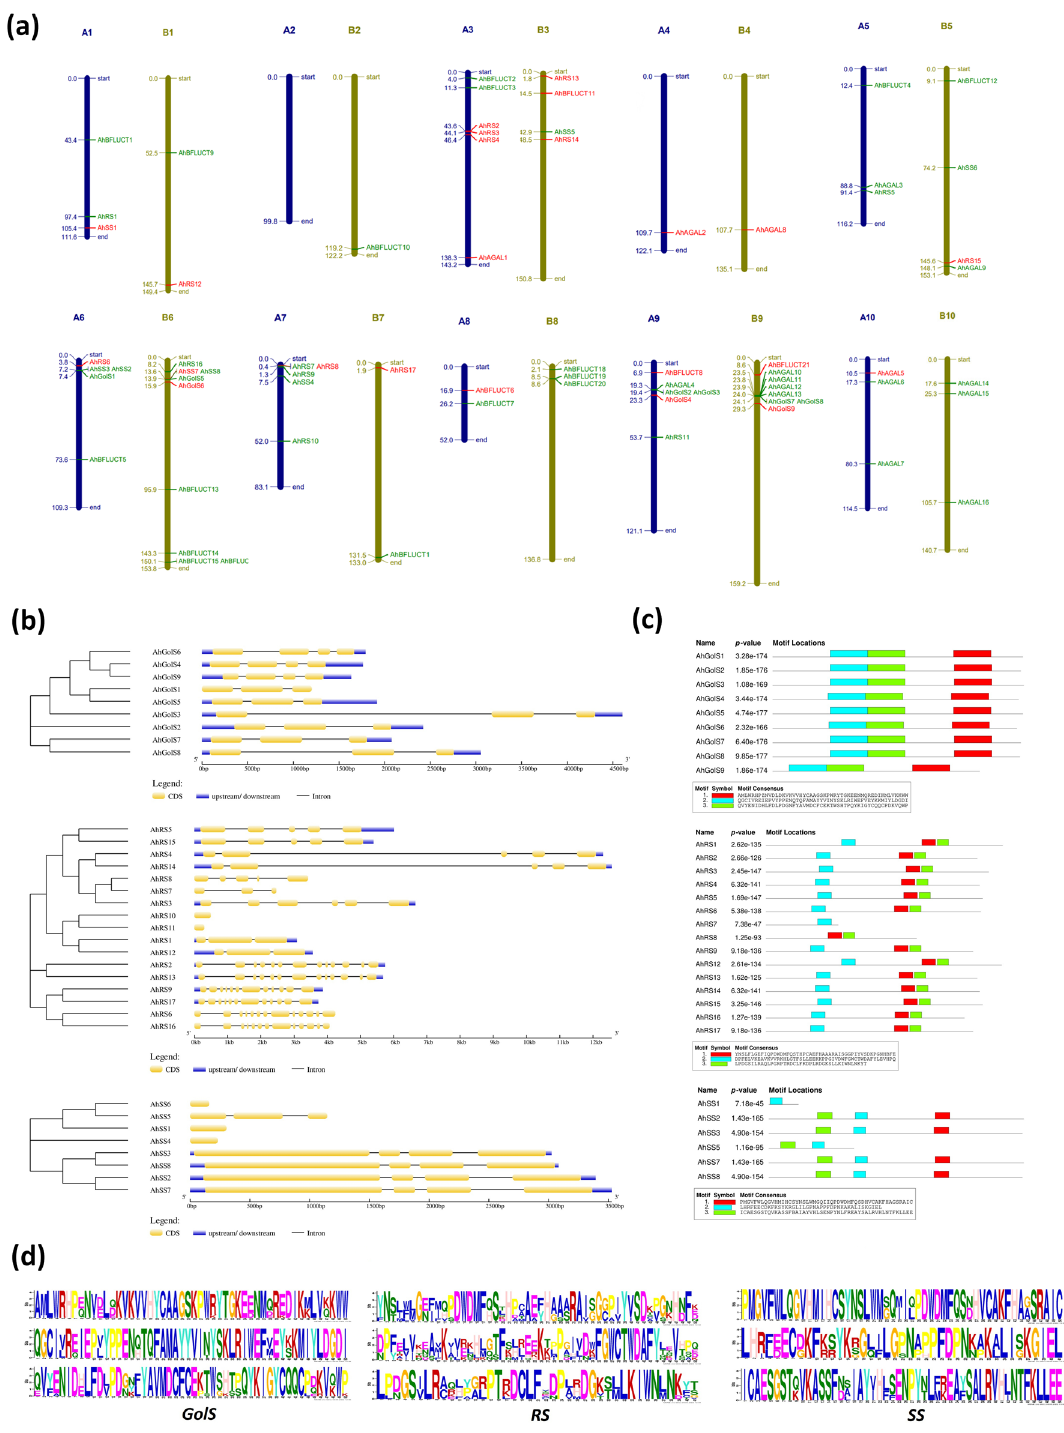
Figure 4. Characterization of RFOs biosynthetic genes in peanut using structural genomics tools. (a) The chromosome wise distribution of Raffinose Family Oligosaccharide genes mapped to the A. hypogaea genome. The scale used for gene location depiction was taken in mega bases (Mb) and drawn using MapChart software. The Differentially Expressed Genes (DEGs) are marked with red. (b) Phylogenetic tree and structures of genes encoding the galactinol synthase ( GolS ), raffinose synthase ( RS ) and stachyose synthase ( SS ) enzymes visualized using GSDS software. (c) The motif compositions of A. hypogaea GolS, RS and SS genes were identified using MEME analysis tool. Each color representing a specific motif. (d) Statistically over-represented sequence within the differential peaks discovered by MEME-ChIP in RFOs biosynthetic